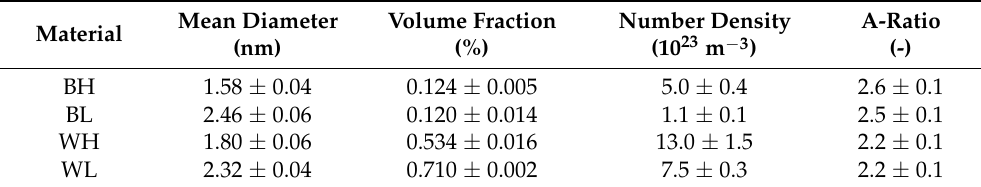
Table 7. Estimates of the mean diameter, volume fraction, number density and A-ratio of irradiation- induced scatterers derived from magnetic